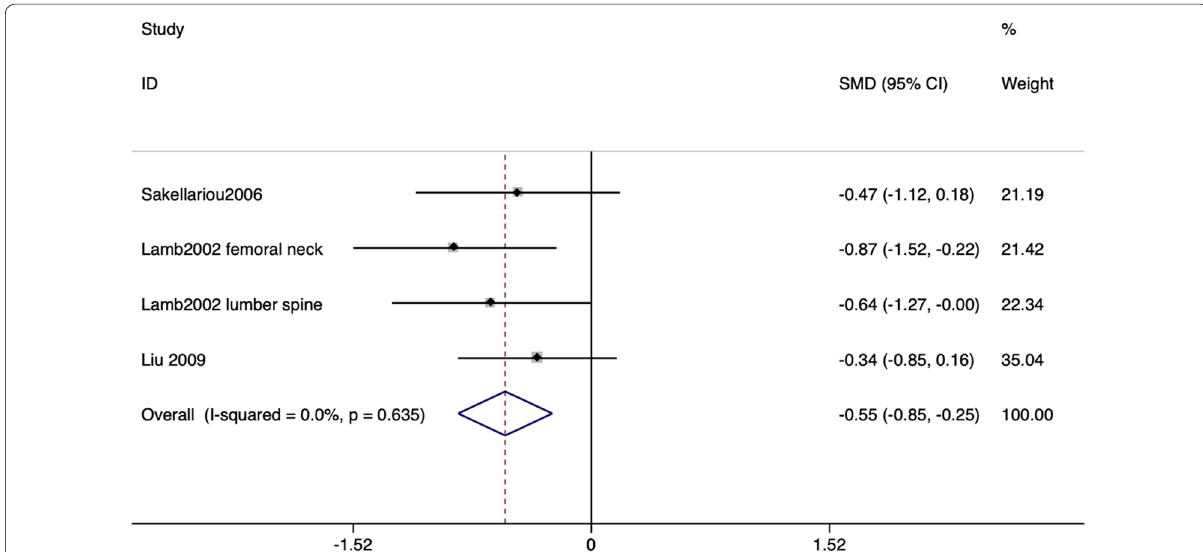
Fig. 3 Pooled standardized mean difference (SMD) for bone mineral density and ulcerative colitis among steroid-free patients. The pooled SMD was calculated using the fixed-effects model